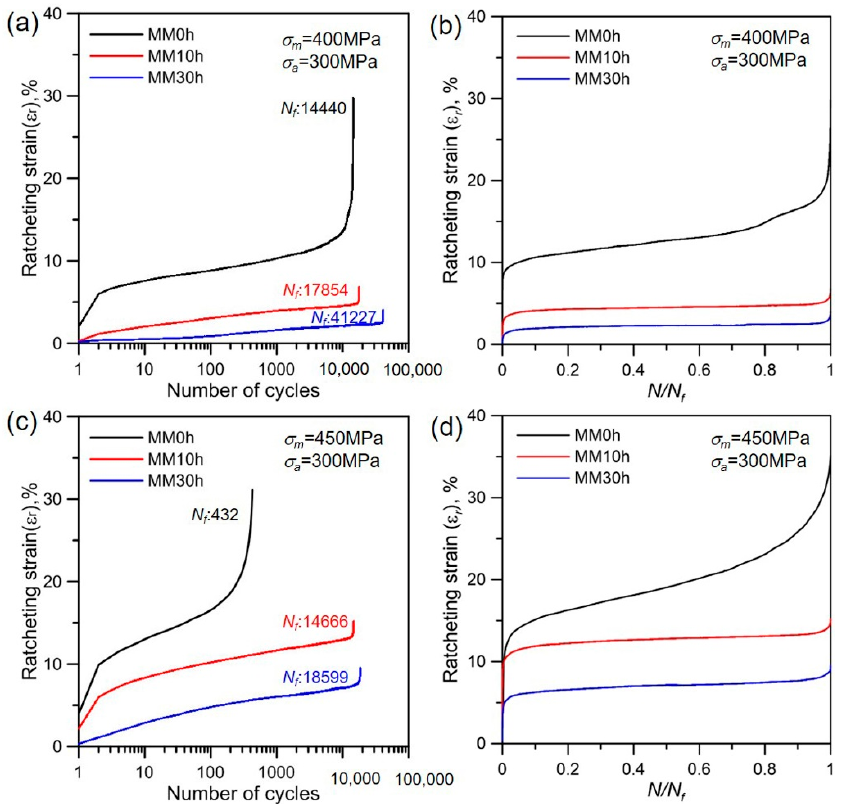
Figure 4. Effects of grain structure on fatigue life ( a , c ) and ratcheting strain ( b , d ) of harmonic- structured SUS316L steels: ( a , b ) σ m = 400 MPa, σ a = 300 MPa; ( c , d ) σ m = 450 MPa, σ a = 300 MPa.